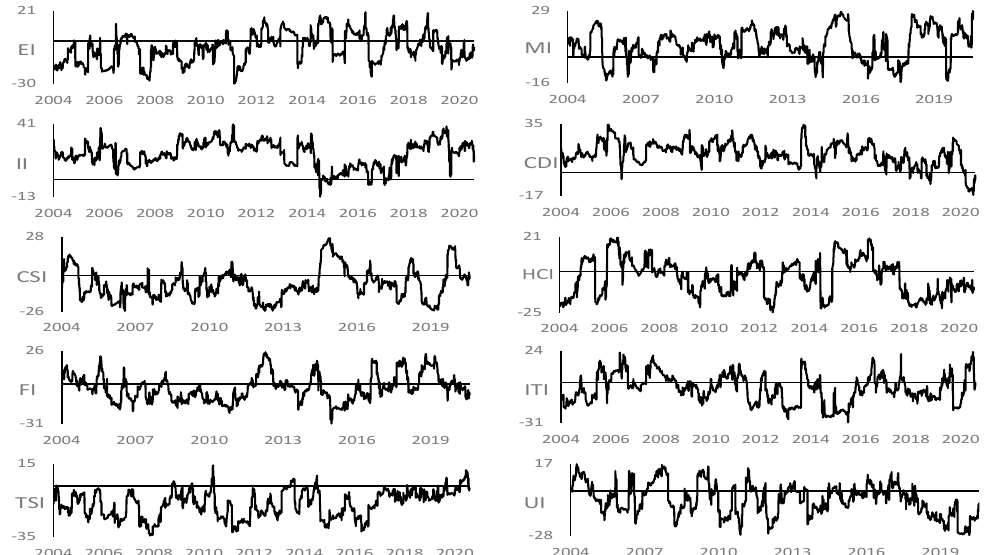
Figure 2. Directed volatility spillover index for 10 sectors in China’s stock market (2004–2020). ( a ) shows the dynamic of “From” spillover index and ( b ) shows the dynamic of “To”spillover index.